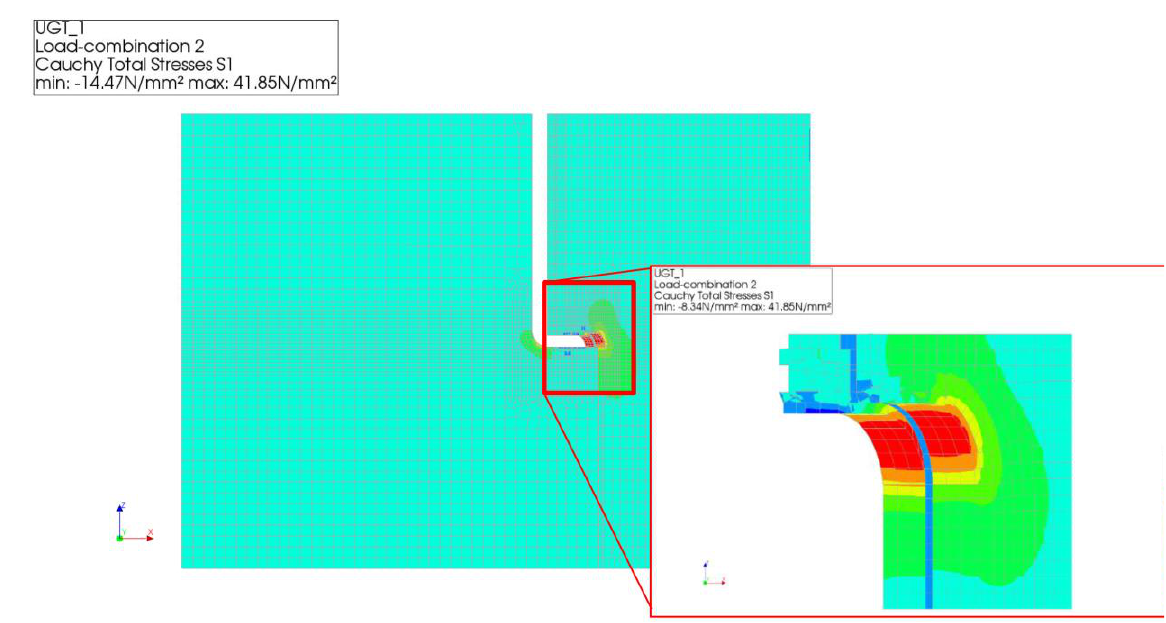
Fig. 11 Contour plot showing stresses for ULS-1 case (dead load and wind load).